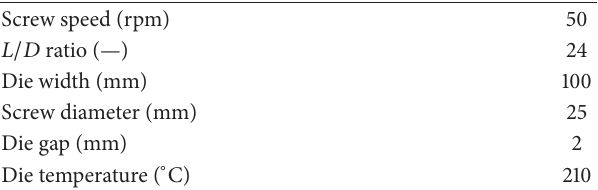
Table 1: Processing parameters.